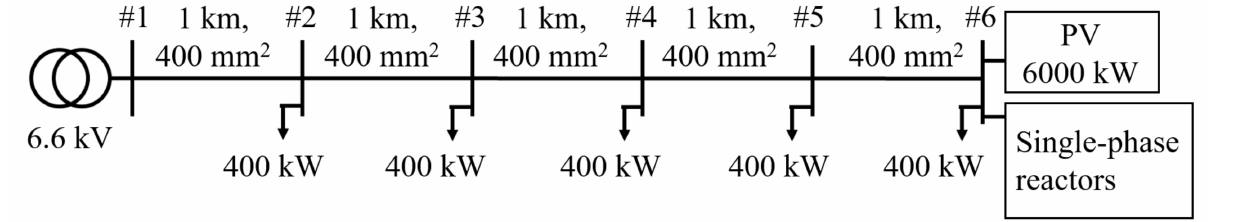
Figure 11. Simulation model with a large PV system and single-phase reactors.